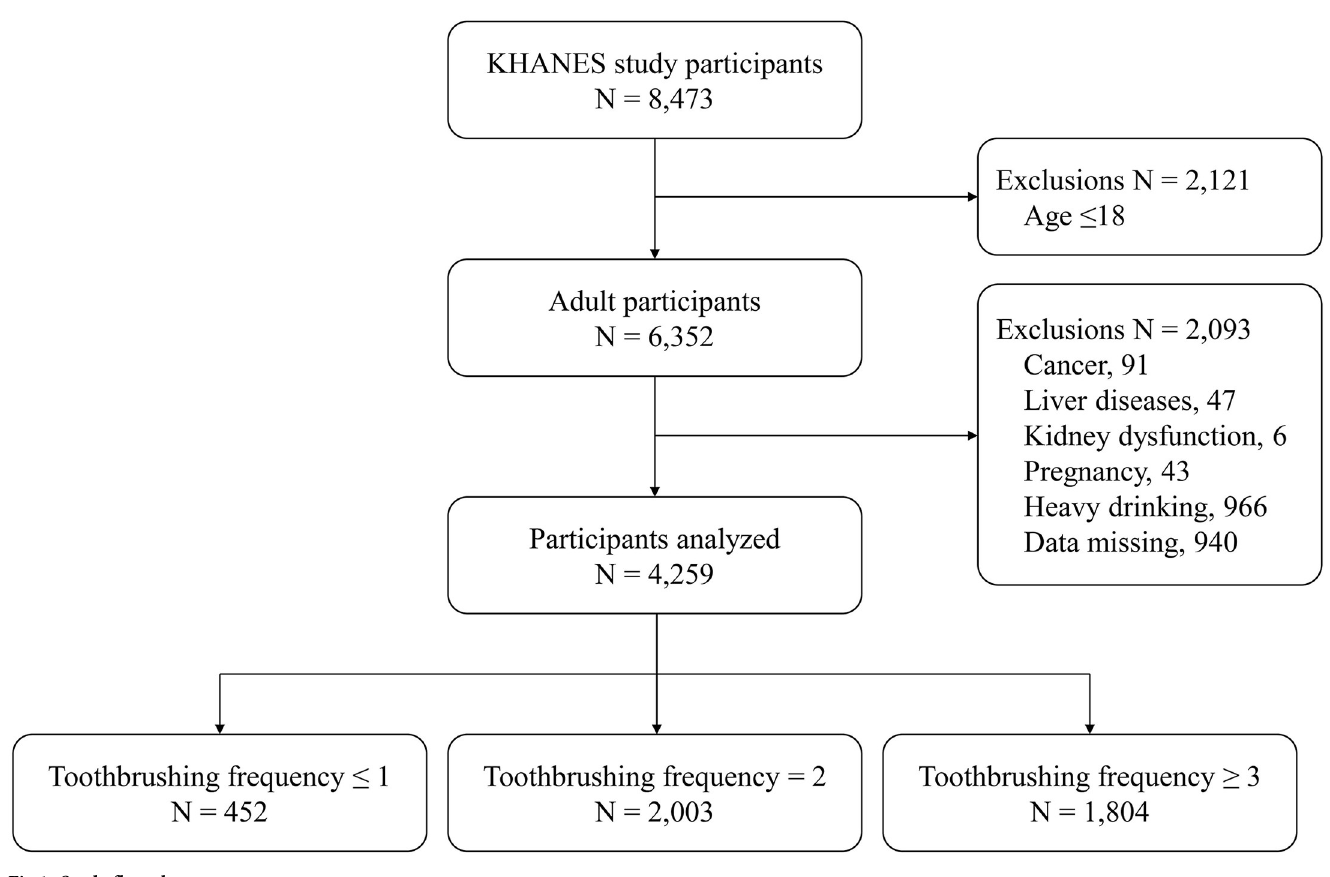
Fig 1. Study flow